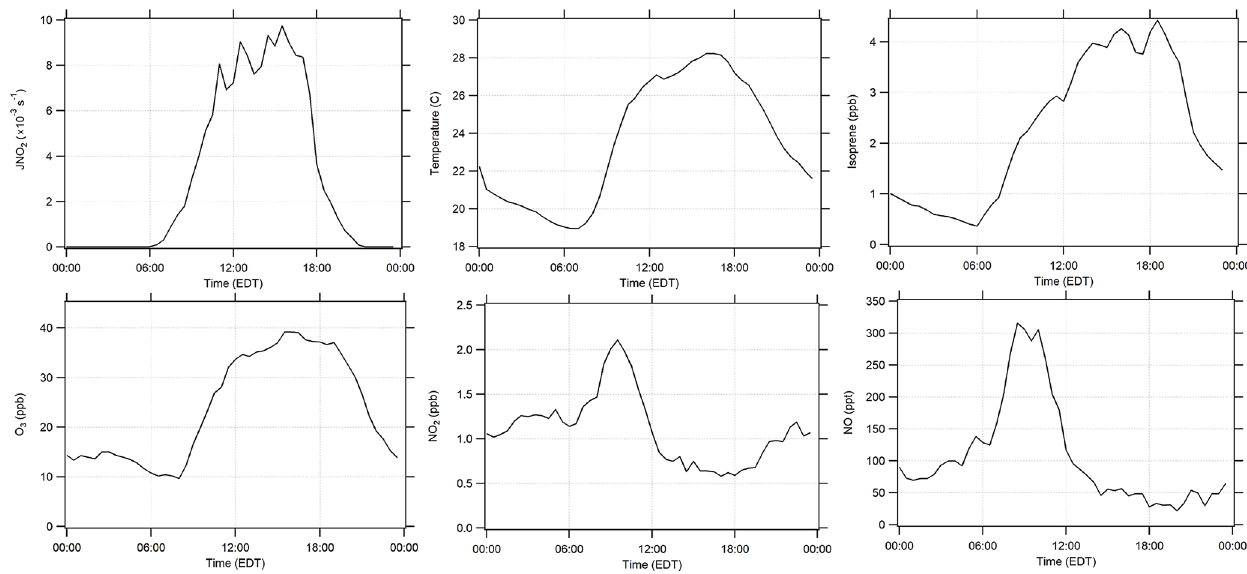
Figure 1. Diurnal campaign average profiles of J ( NO 2 ) , temperature, isoprene, O 3 , NO 2 , and